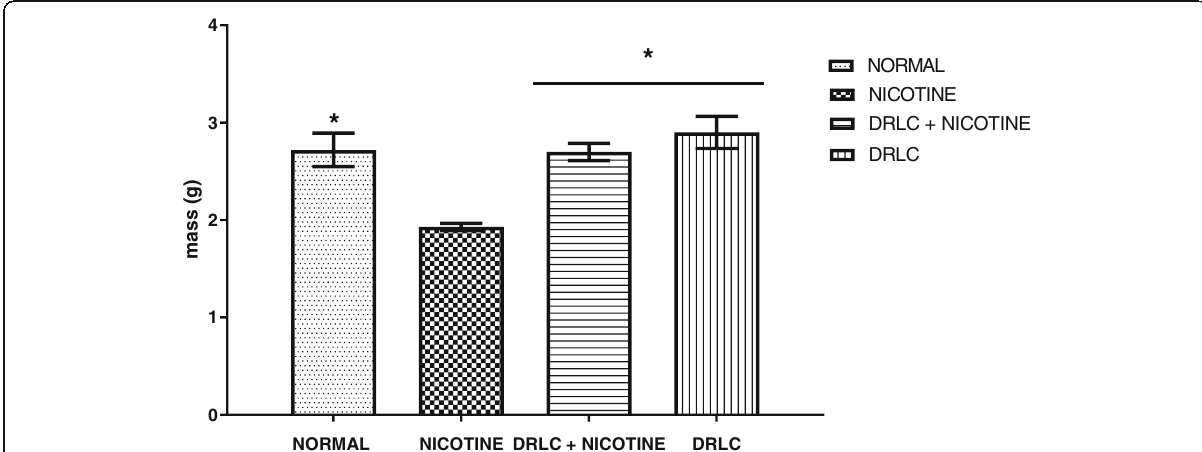
Fig. 1 Chart showing the testicular mass of the experimental animals. Values are mean ± SEM. N =5. *Statistically different from nicotine group at p <